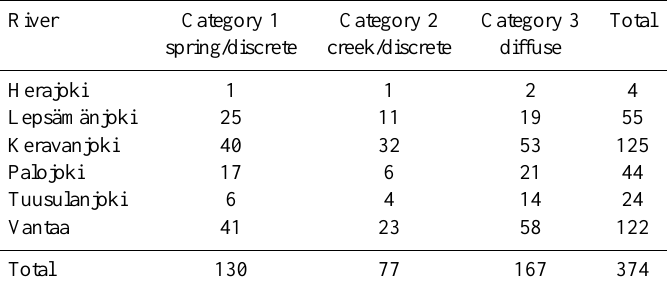
Table 2. Discrete and diffuse groundwater discharge areas identified in the AIR surveys conducted in 2010 and 2011 classified into three categories. River Category